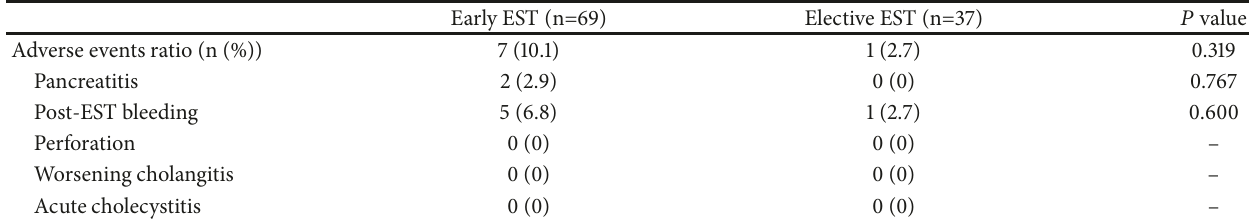
Table 5: Comparison of adverse events between early and elective endoscopic sphincterotomy.